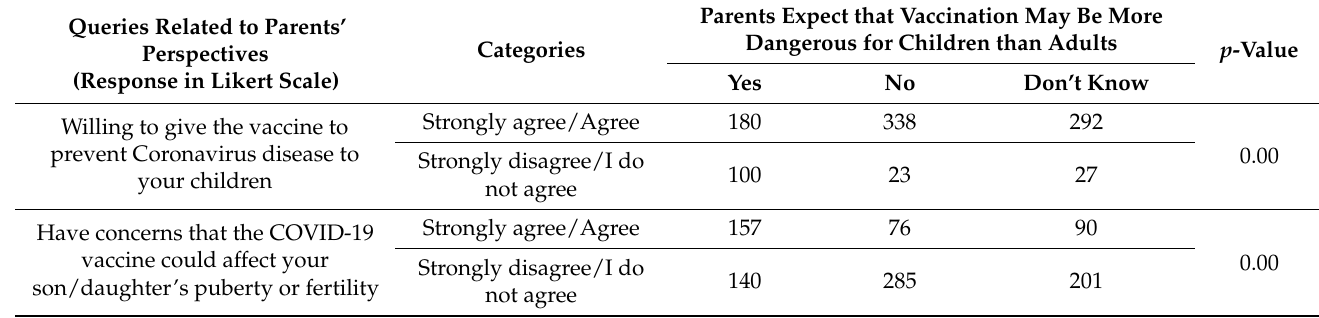
Table 5. Parent’s Perspectives on the COVID-19 Vaccine and their concern toward children’s vaccina- tion. (response in Likert